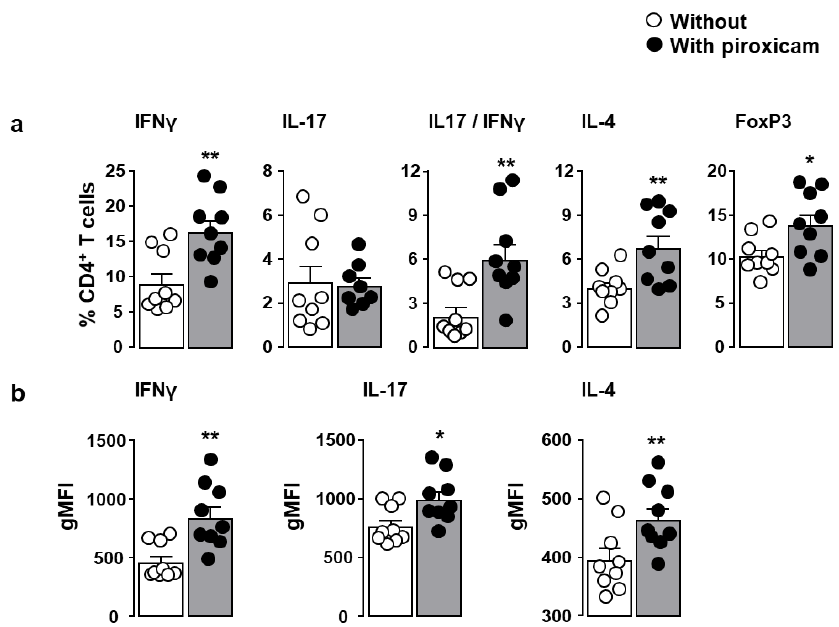
Figure 3. Frequency of CD4 + T lymphocytes with Th1, Th17, Th2, and Treg (regulatory T cells) phenotypes in IL-10 -/- mice fed with piroxicam. IL-10 -/- mice were fed with standard chow diet without (white circles) or with piroxicam (black circles) for 10 days. The frequencies of CD4 + T lymphocytes producing IFN γ (Th1), IL-17 (Th17), both IFN γ and IL-17 (Th17), or IL-4 (Th2), as well as CD4+ T lymphocytes expressing the lineage specification transcriptional factor Foxp3 (Treg) within lamina propria , were analyzed by cytofluorometry ( a ). The corresponding cytokine expression levels expressed as geometric mean of fluorescence intensity (gMFI) are depicted in panel ( b ). Each symbol represents 1 mouse ( n = 9/group). Statistical analysis was performed using the Mann–Whitney U test.* p < 0.05, ** p < 0.01.